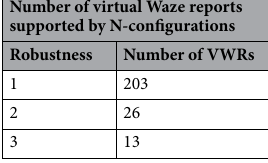
Table 3. Robustness of Virtual Waze Reports. Robustness is measured on a scale of 1–3, based on the number of N-configurations that support a given